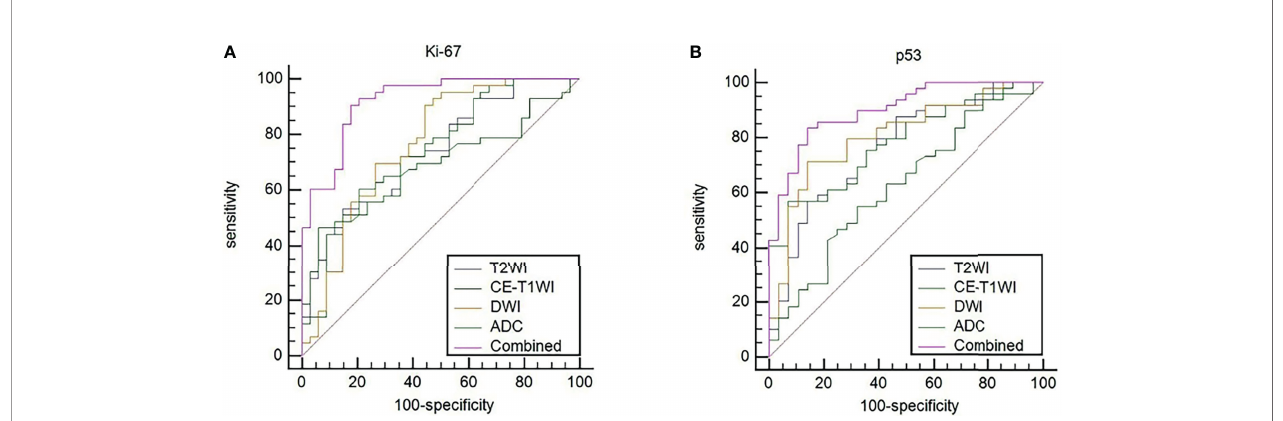
FIGURE 4 | (A) ROC curves to predict Ki-67 expression levels in EC. (B) ROC curves to predict p53 expression levels in EC. Equality of AUC was assessed by the DeLong ’ s